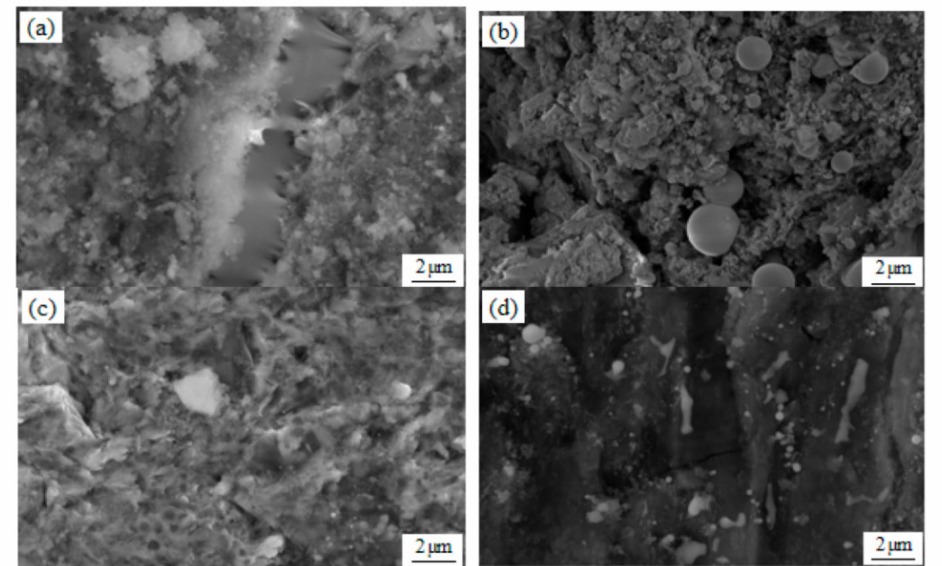
Figure 2. Scanning electron microscopy (SEM) image at 5000 × of the aluminum alloy when the ratio of Ga-In-Sn is 7:2:1 and 6:3:1: ( a ) 50 wt.%Al-50 wt.%Ga-In-Sn (GIS) (7:2:1), ( b ) 50 wt.%Al-50 wt.%GIS (6:3:1), ( c ) 80 wt.%Al-20 wt.%GIS (7:2:1), and ( d ) 80 wt.%Al-20 wt.%GIS